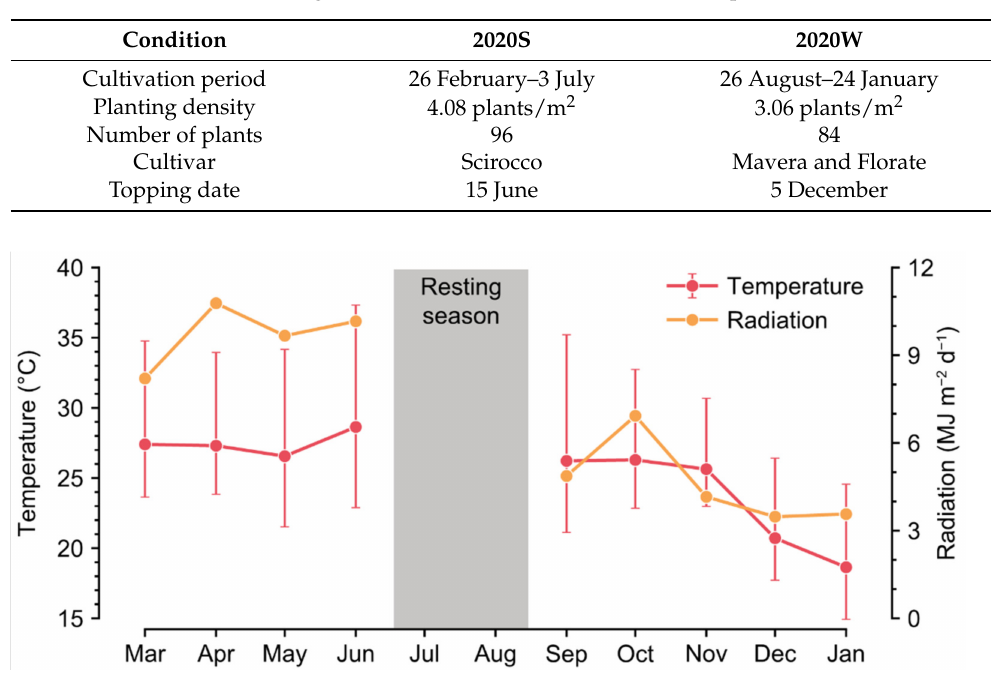
Table 1. Cultivation and management conditions in different cultivation periods.